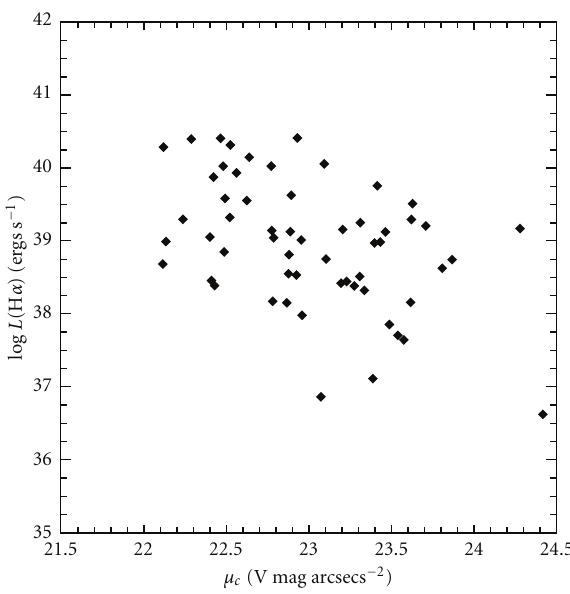
Figure 11: Central surface brightness versus H α luminosity. There is a weak correlation between central stellar density and the global H α luminosity for LSB galaxies. There are numerous avenues of speculation from an increased number of ionizing UV photons with higher stellar density to higher gas surface densities leading to higher star formation